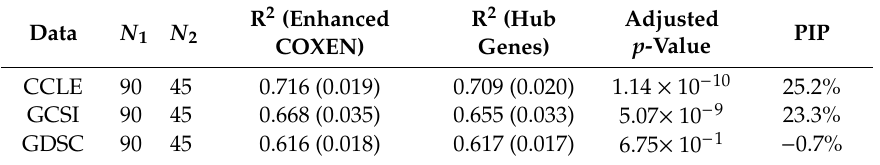
Table 6. Comparison in the performance of prediction models built based on genes selected by the enhanced COXEN method and that of models built based on the hub genes derived from network